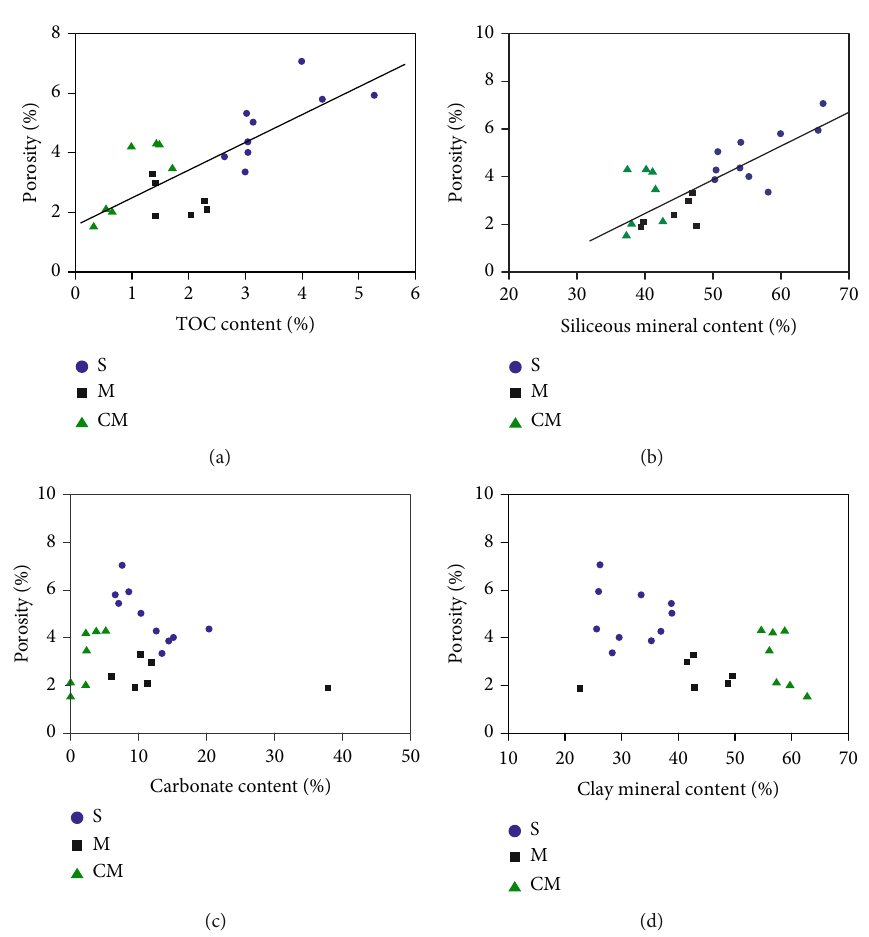
Figure 10: Relationship between porosity and (a) TOC content, (b) siliceous minerals content, (c) carbonate content, and (d) clay minerals content of shale